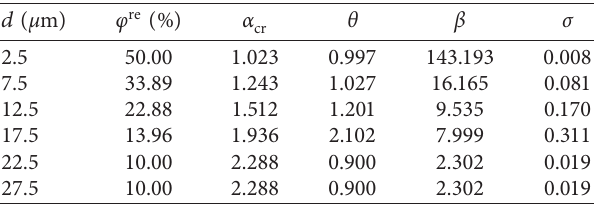
Table 14: Parameter values for PLN distribution.